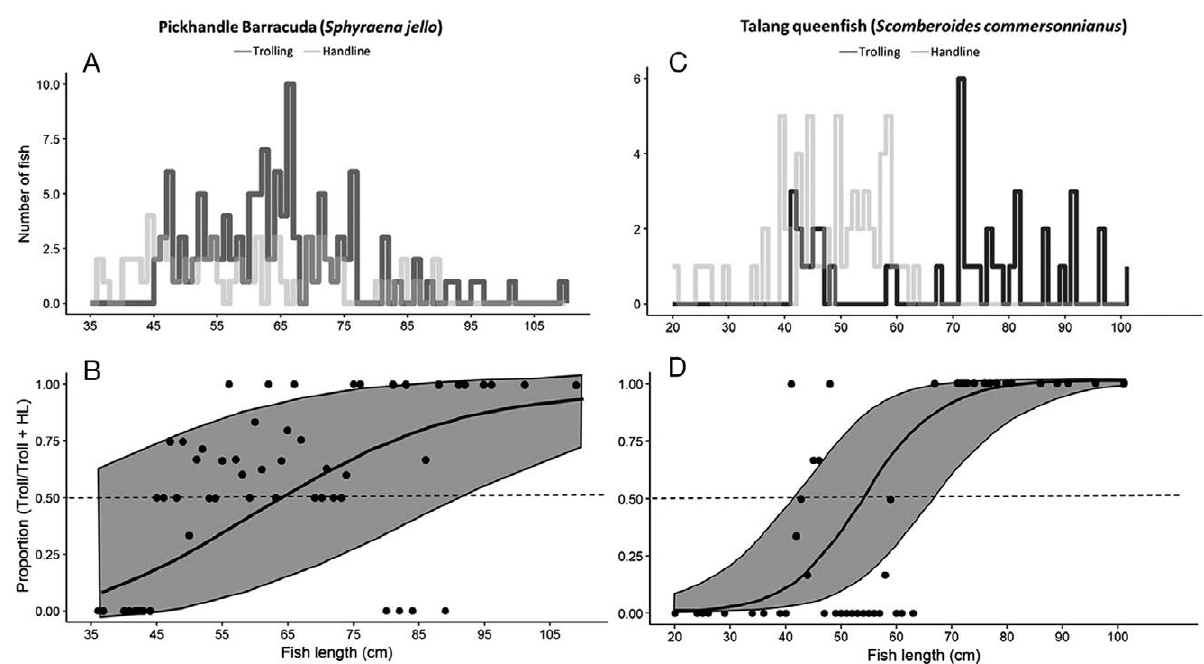
Fig. 3. – Length frequency of pickhandle barracuda (A) and talang queenfish (C) from trolling (solid line) and handline (dashed line) gear. Catch proportions [trolling/(trolling + handline)] between gears (circles) and GLMM-modelled proportions of catch-at-length by trolling and handline gear for pickhandle barracuda (B) and talang queenfish (D). Predicted mean is the black line and grey areas are the 95% confidence intervals. A value of 0.5 indicates an even split between gears for the specific length; a value of 0.75 indicates that 75% of fish caught at this length were captured by trolling and 25% by handline gear. Table 2. – Observed mean catch rate (fish hr –1 ), standard error of the mean, percent catch rate change, likelihood ratio statistics ( χ 2 ), and p-values between paired handline and trolling trials. * denotes statistical difference at an α of 0.05. Species